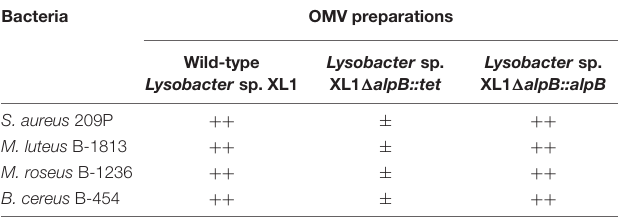
TABLE 4 | Lytic action of vesicles.